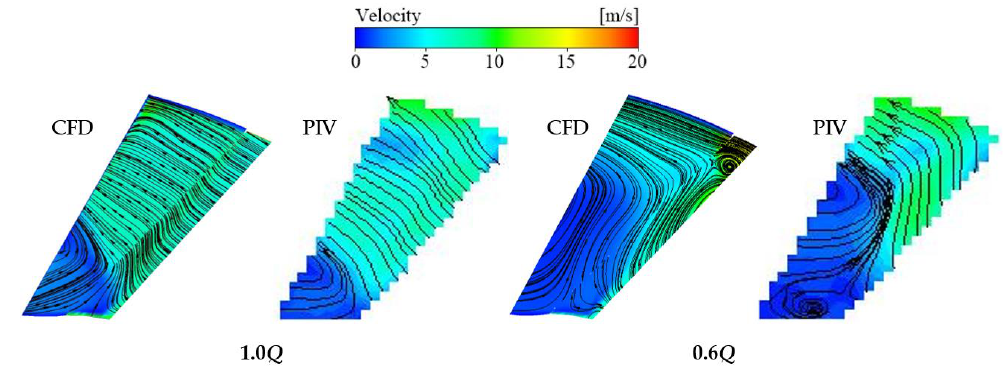
Figure 5. Comparison of CFD and PIV test results.